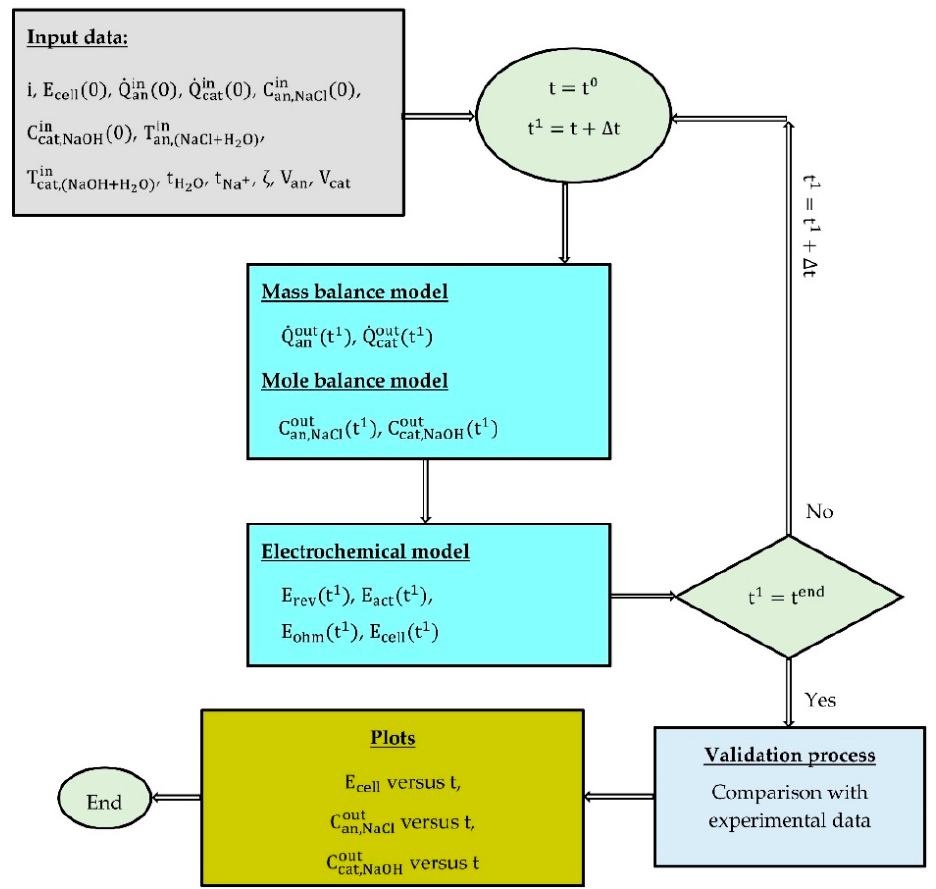
Figure 3. MATLAB program flow chart showing calculation steps followed to calculate process